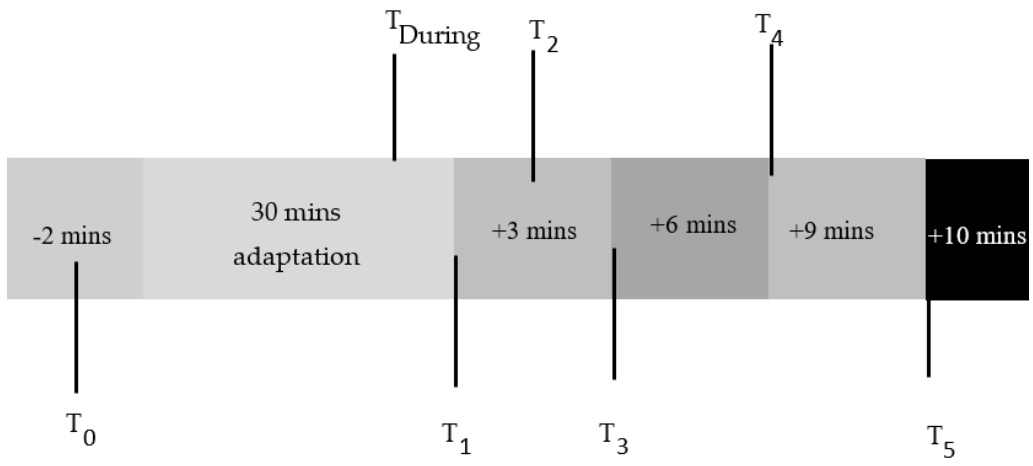
Figure 3. Flow chart indicating the epochs of interest for data analysis.